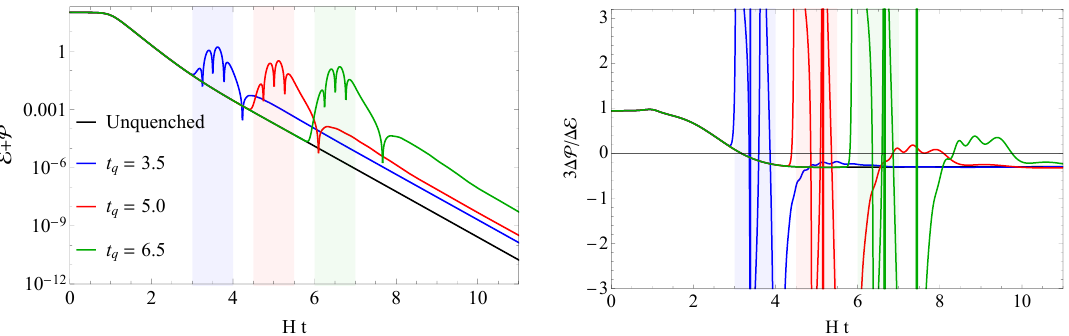
Figure 8 . Evolution of E + P (left) and 3∆ P / E (right) for H = 1 quenched with different amplitude at different times. The quenches are realised by exciting the boundary metric with Gaussian perturbations whose widths are indicated by the red, green and blue bands. The quench performs work on the system, which leads to an increase of E and explains the increase of E + P . After the quench the ratio of pressure and energy density quickly returns to the late-time value of the unquenced evolution (the small oscillations are verified to be numerical